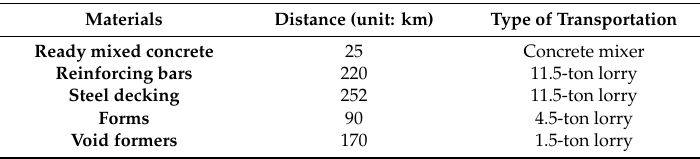
Table 2. Distance of suppliers and transportation